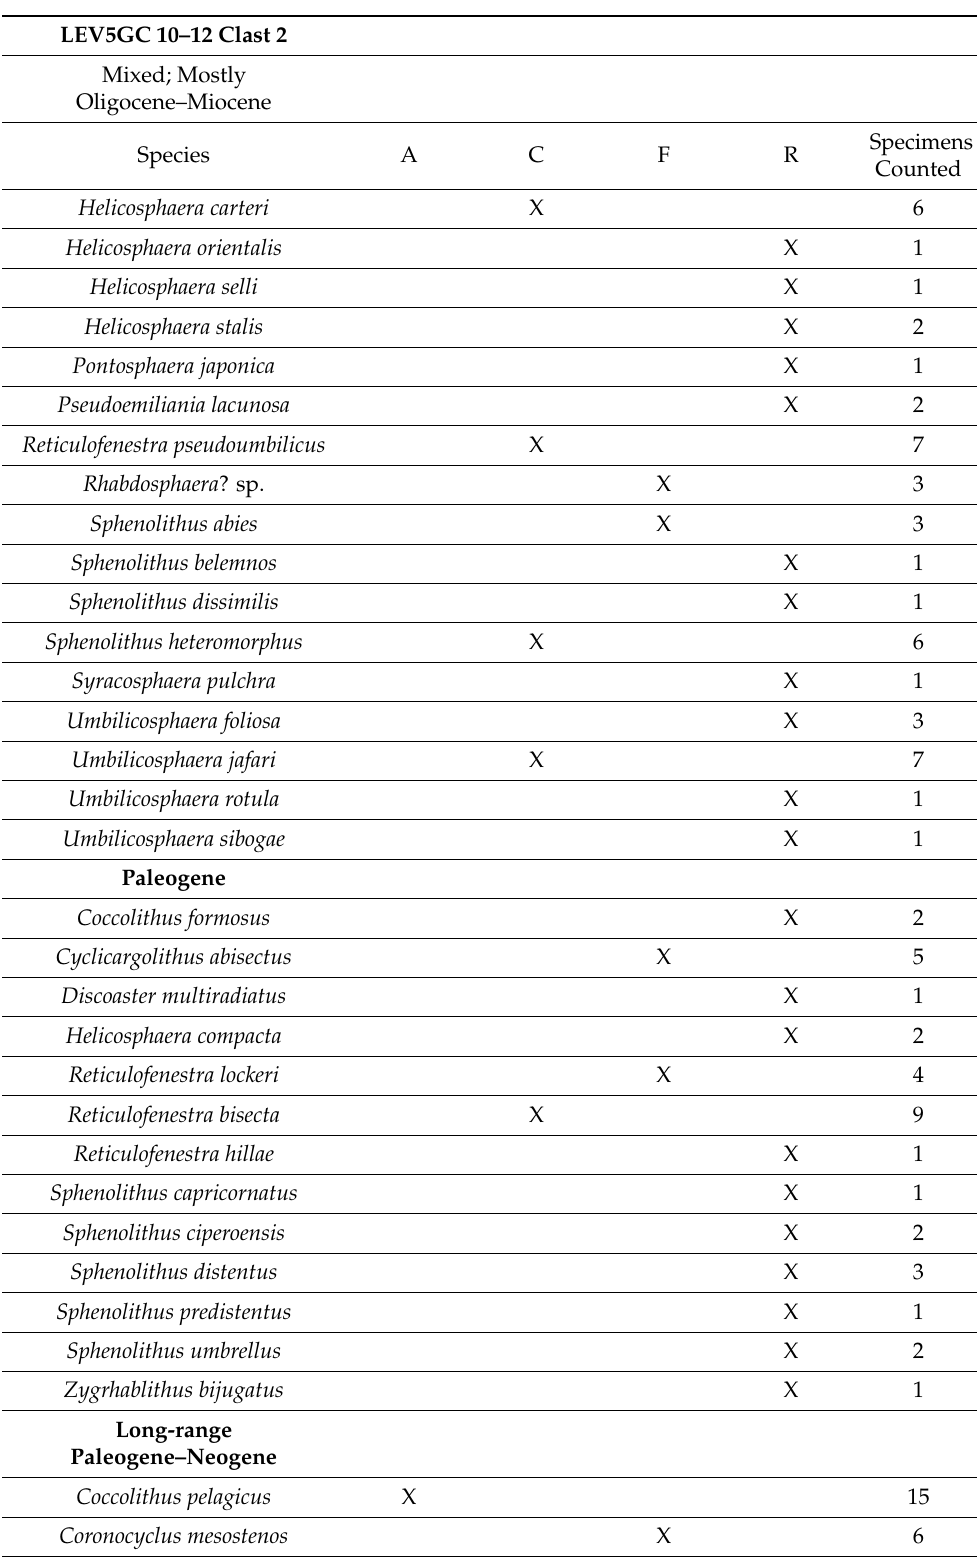
Table A19. Cont. LEV5GC 10–12 Clast 2 Mixed;